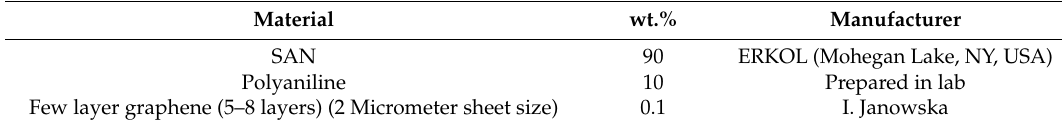
Table 2. Ingredients for SAN/PANI/FLG